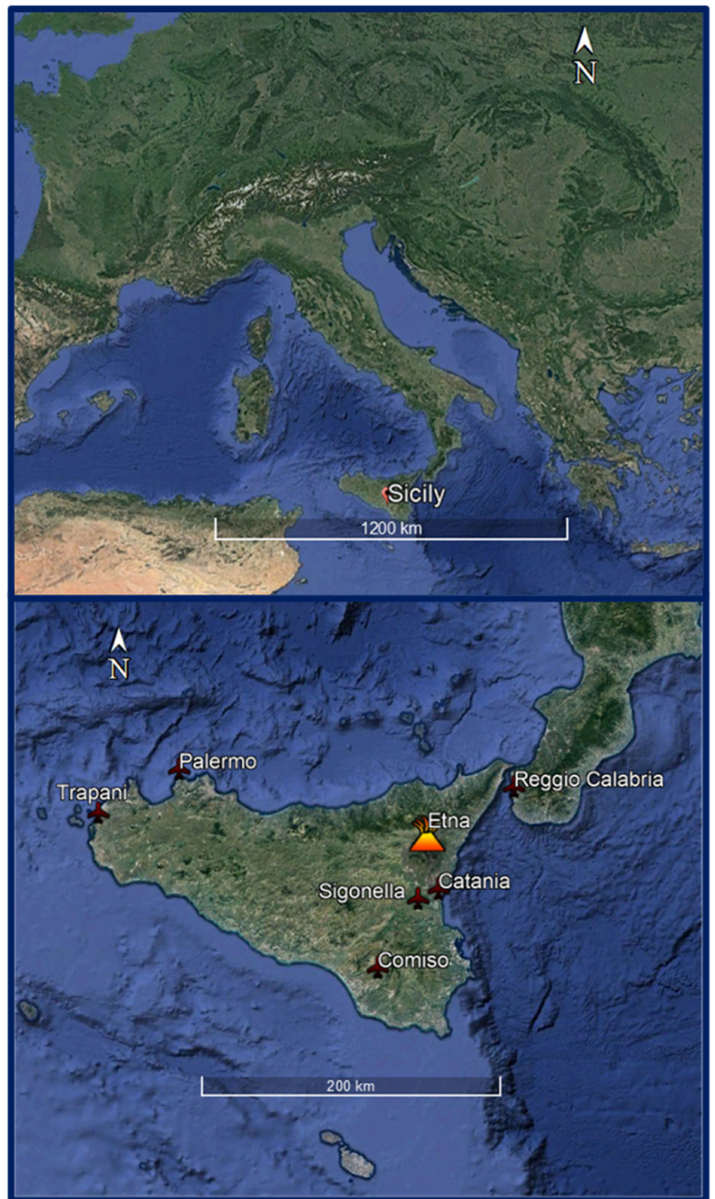
Figure 1. Top panel: map showing the location of Sicily in Europe. Bottom panel: airports a ff ected by the eruptive activity of the volcanic area of